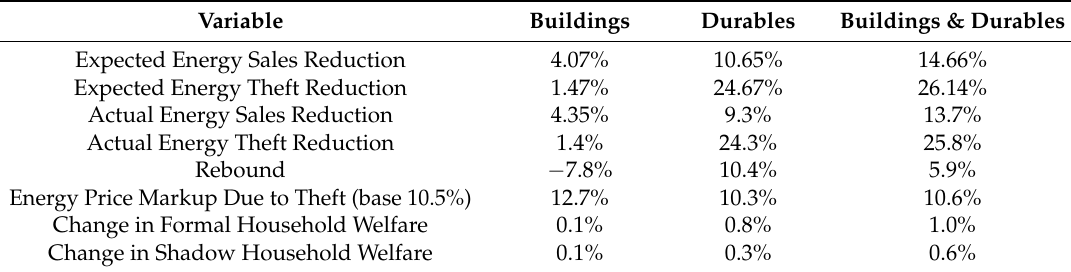
Table 2. Turkey Model Estimation with Informal Sector and Energy